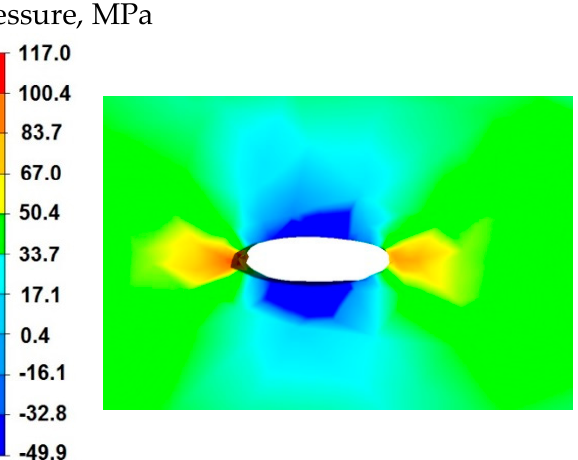
Figure 8. Distribution of hydrostatic pressure values within the modeled discontinuity at a 20% reduction.